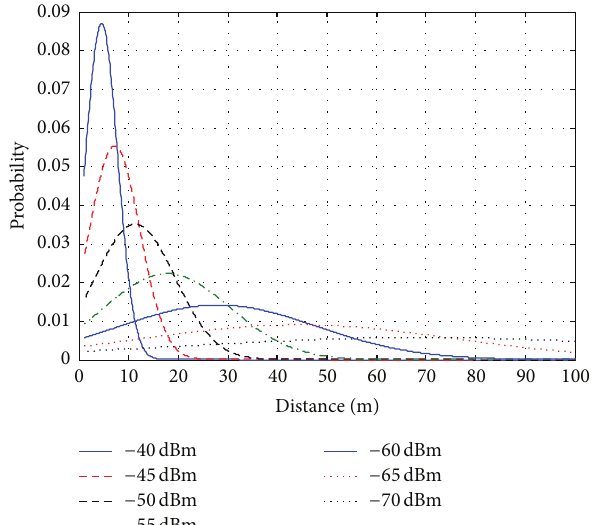
Figure5:WiFideterministicpropagationmodelcomparedtomeas- urements.